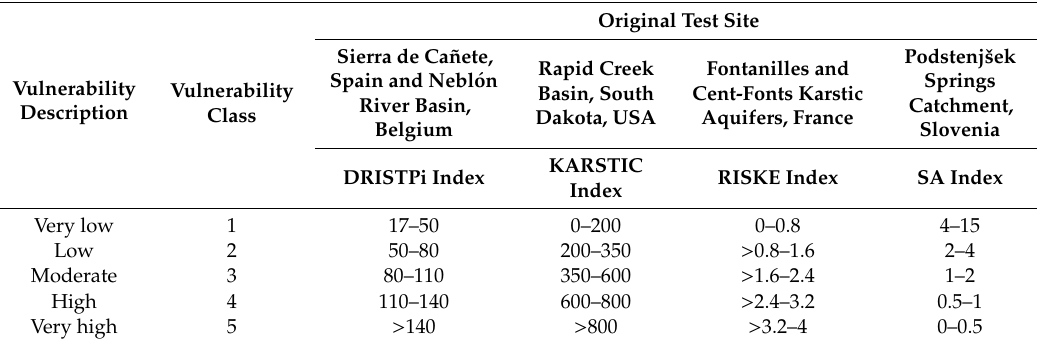
Table 2. Vulnerability classes and index variation according di ff erent